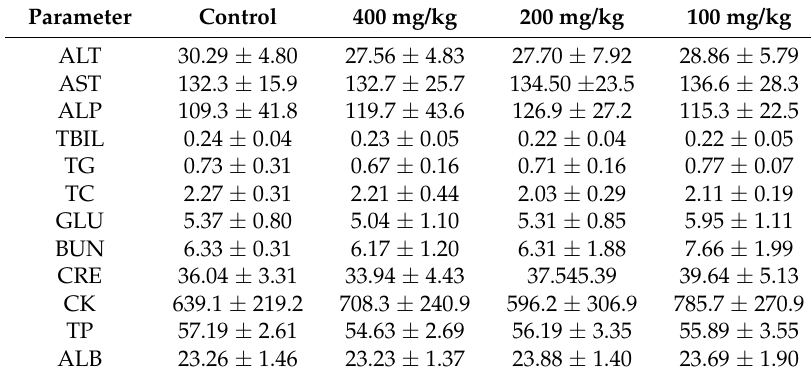
Table 2. Effects of repeated administration of β -EA on blood biochemical parameters in mice treated for 4 weeks (mean ± SD, n = 10).